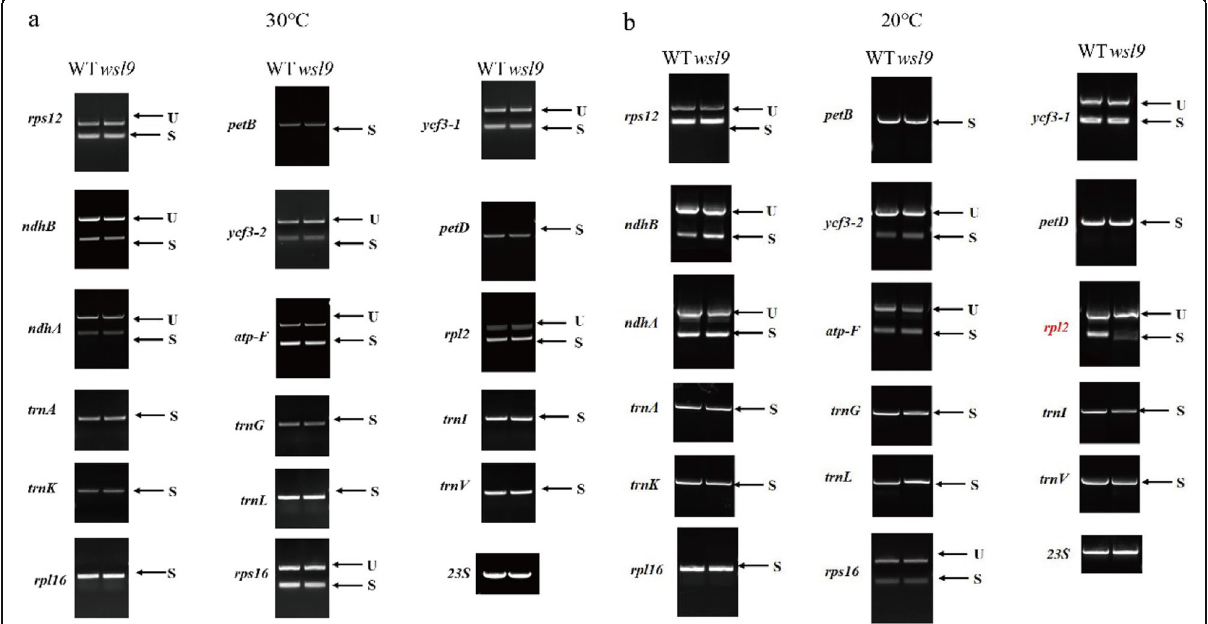
Fig. 7 Splicing of chloroplast transcripts in WT and wsl9 mutant at different temperature. a Splicing of chloroplast transcripts in WT and wsl9 mutant at 30 °C. b Splicing of chloroplast transcripts in WT and wsl9 mutant at 20 °C. Gene transcripts are labeled at the left. Spliced (S) and unspliced (U) transcripts are indicated at the right. RT-PCR was performed with RNA was extracted from WT and wsl9 mutant at the three-leaf stage. 23S rRNA was used as the reference